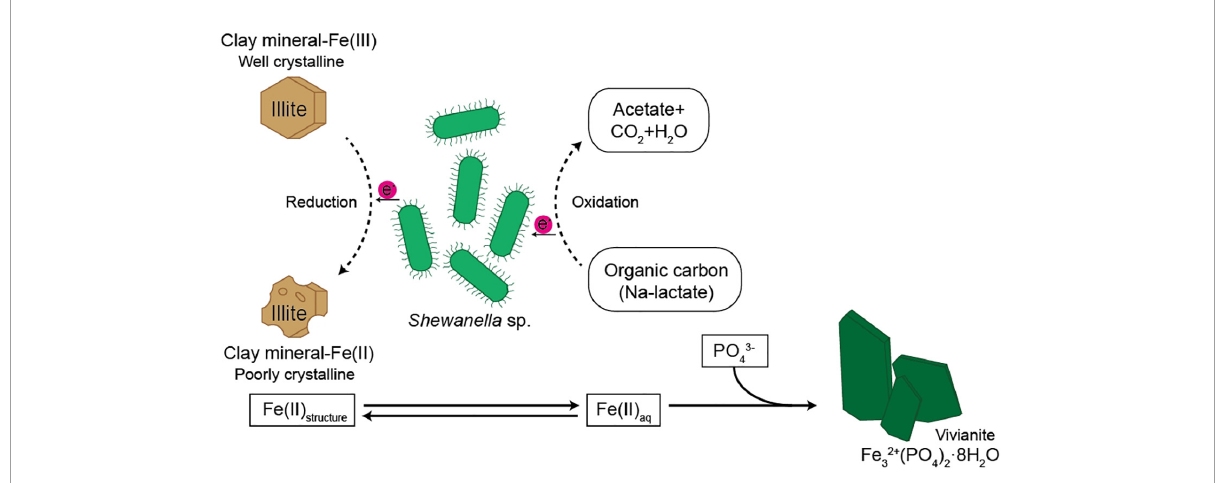
FIGURE6 Schematic diagram showing possible pathway of Fe cycle and electron transfer from microbe to the structural Fe(III) of the clay